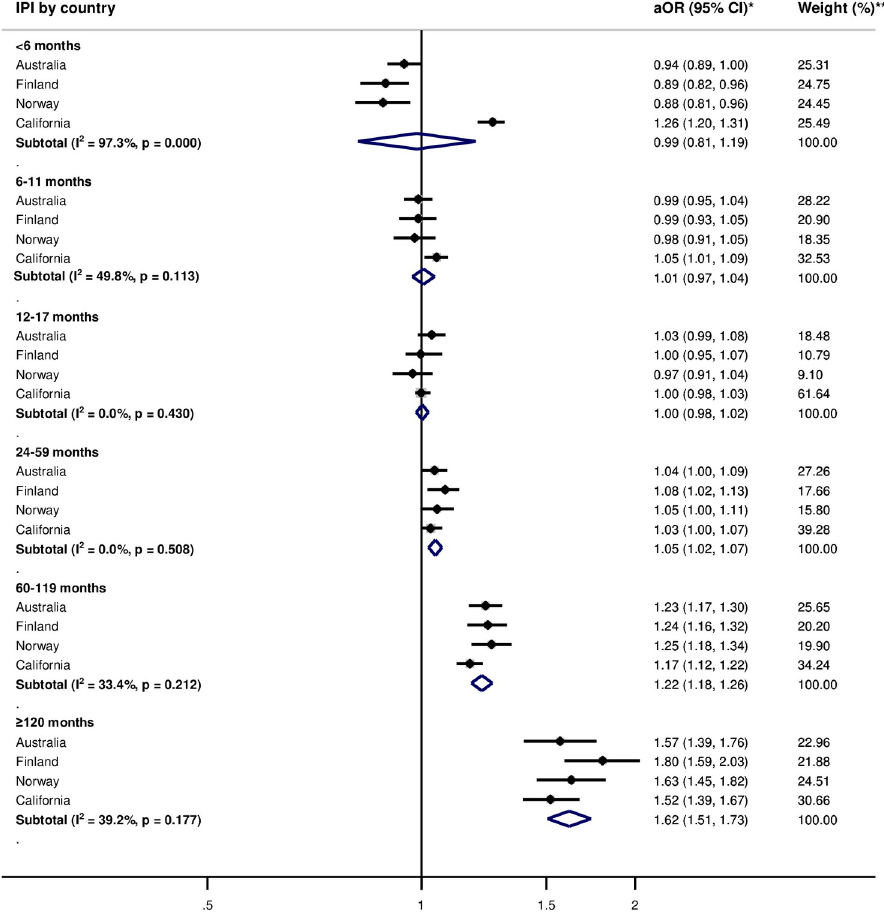
Fig 3. Adjusted odds ratios for the within-women analysis for the association between interpregnancy interval and small-for-gestational age birth as compared to 18–23 months of interpregnancy interval by country. IPI— interpregnancy interval. � Adjusted Odds ratios (aOR) and corresponding 95% confidence intervals, adjusted for maternal age, parity, and birth year; the reference IPI category is 18–23 months. �� Weights are derived from inverse-